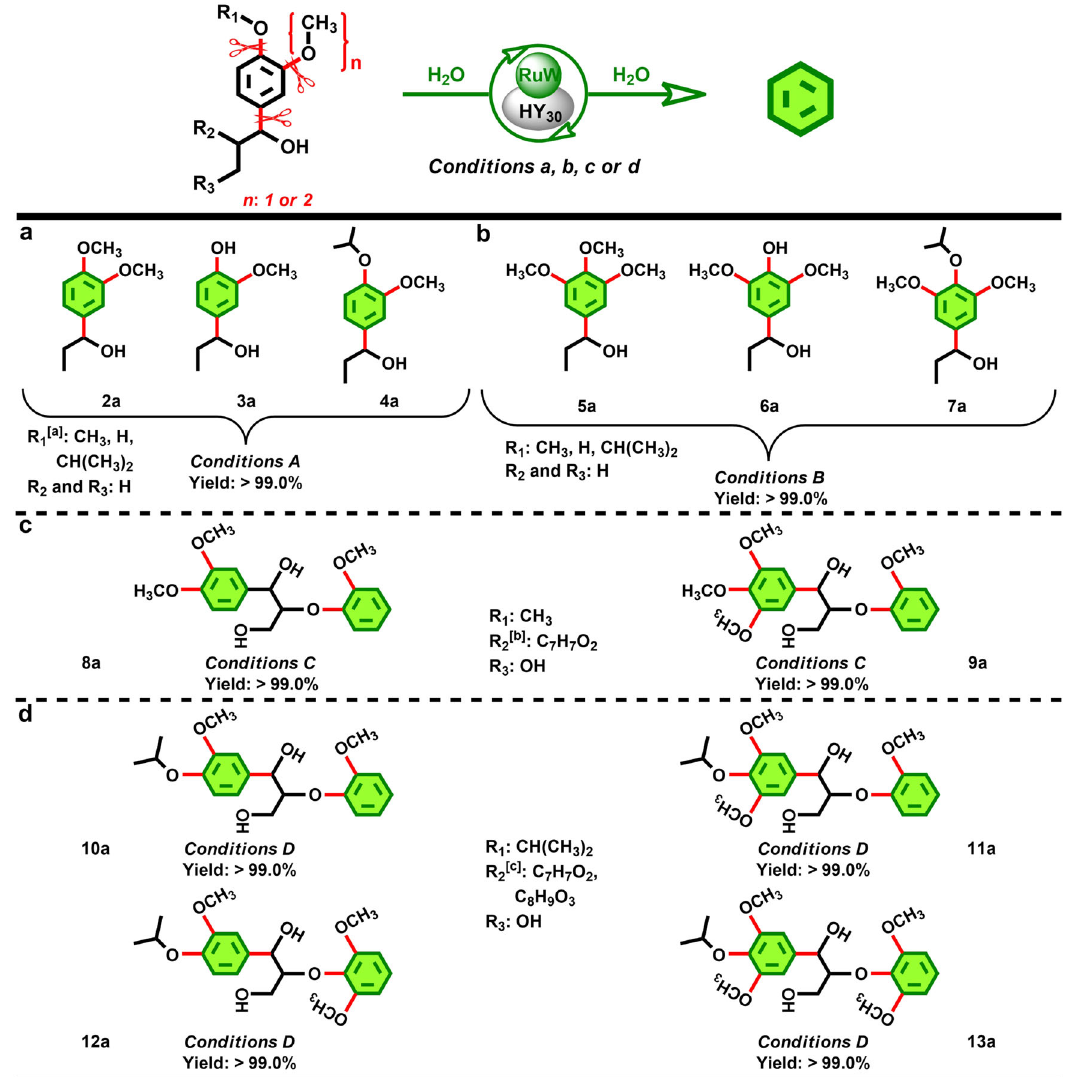
Fig. 4 In situ re fi ning strategy: portfolio scope of the C sp2 – C sp3 and C sp2 – O bonds. The general reaction scheme is shown at the top. The chemical bonds colored with red is transformed, and the benzene ring colored with green is the desired product from the in situ re fi ning strategy. Yields of benzene product provided are at full conversion of substrates, as averages of three experiments conducted in parallel. a CH(CH 3 ) 2 , isopropyl. b C 7 H 7 O 2 , 2-methoxyphenoxyl. c C 8 H 9 O 3 , 2, 6-dimethoxyphenoxyl. Reaction conditions: H 2 O (5.0 mL), 0.1 MPa N 2 , 800 rpm. Conditions a: Substrate (1.0 mmol), RuW/HY 30 catalyst (0.25 g, 3.0 wt% Ru, 17 wt% W), 190 °C, 7.0 h. Conditions b: Substrate (1.0 mmol), RuW/HY 30 catalyst (0.30 g, 3.0 wt% Ru, 17 wt% W), 200 °C, 7.5 h. Conditions c: Substrate (0.5 mmol), RuW/HY 30 catalyst (0.35 g, 3.5 wt% Ru, 20 wt% W), 210 °C, 8.0 h. Conditions d: Substrate (0.5 mmol), RuW/HY